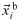
Interactions in the the MEDYAN model.A) A Schematic representation of two arbitrary points on the cylinders i and j, used to calculate excluded volume interactions. B) Representation of branching points. Position of the branching point x→ib on the “mother” filament is determined by a stochastic chemical reaction. C) Representation of the motor as a potential between two points x→im and x→jm on bound cylinders. Positions of the binding points α and β are determined by stochastic chemical reactions.